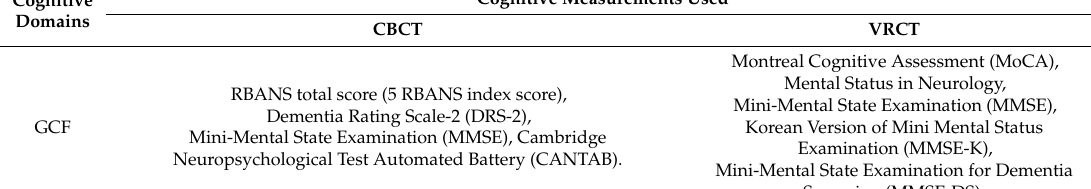
Cognitive Domains